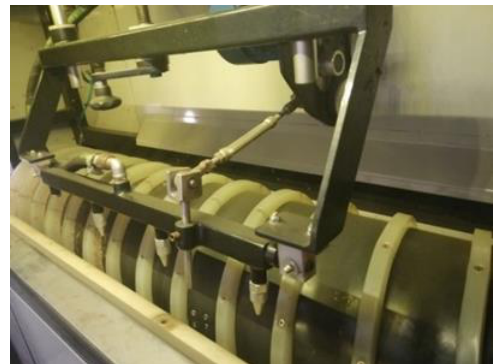
Figure 8. System for blowing off the incised outer layer (scales).